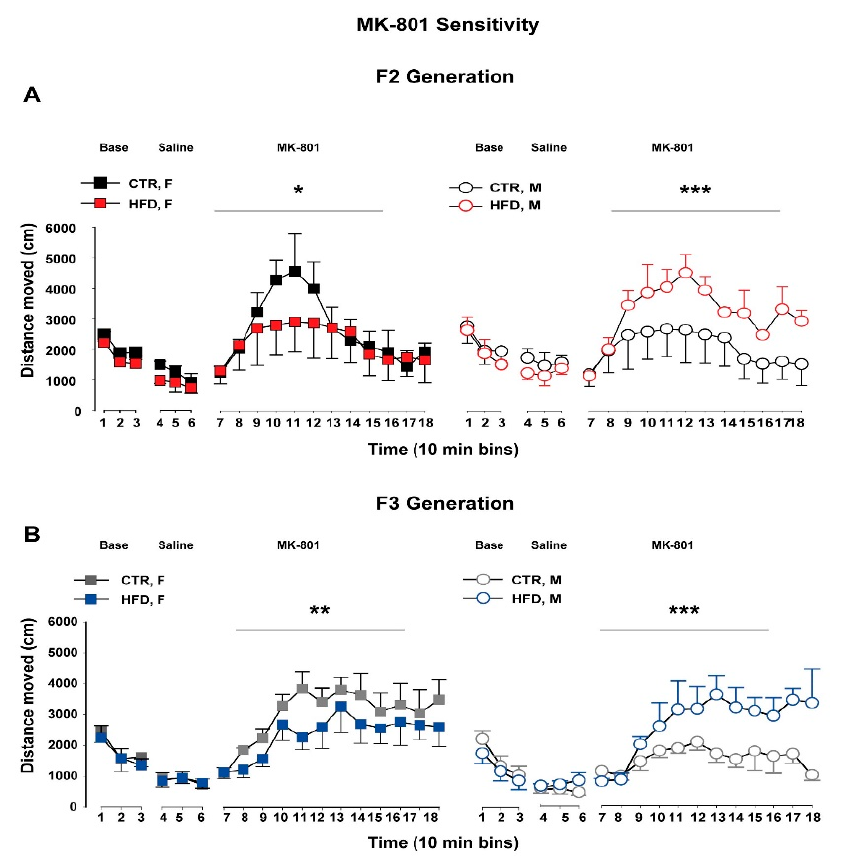
Figure 3. MK-801 sensitivity test in the F2 and F3 offspring. The line plot shows locomotor activity in the open field expressed as distance traveled (cm) per 10-min bin during baseline, following saline administration and following a systemic MK-801 injection in F2 ( A ) and F3 ( B ) offspring. N (F2 CTR) = (4 M, 4 F), N (F2 HFD) = (4 M, 4F), N (F3 CTR) = (5 M, 5 F), N (F3 HFD) = (4 M, 5F). All values are means ± SEM. * p < 0.05; ** p < 0.001; *** p < 0.0001. HFD = high-fat diet, CTR = control diet, F = female, M = male.